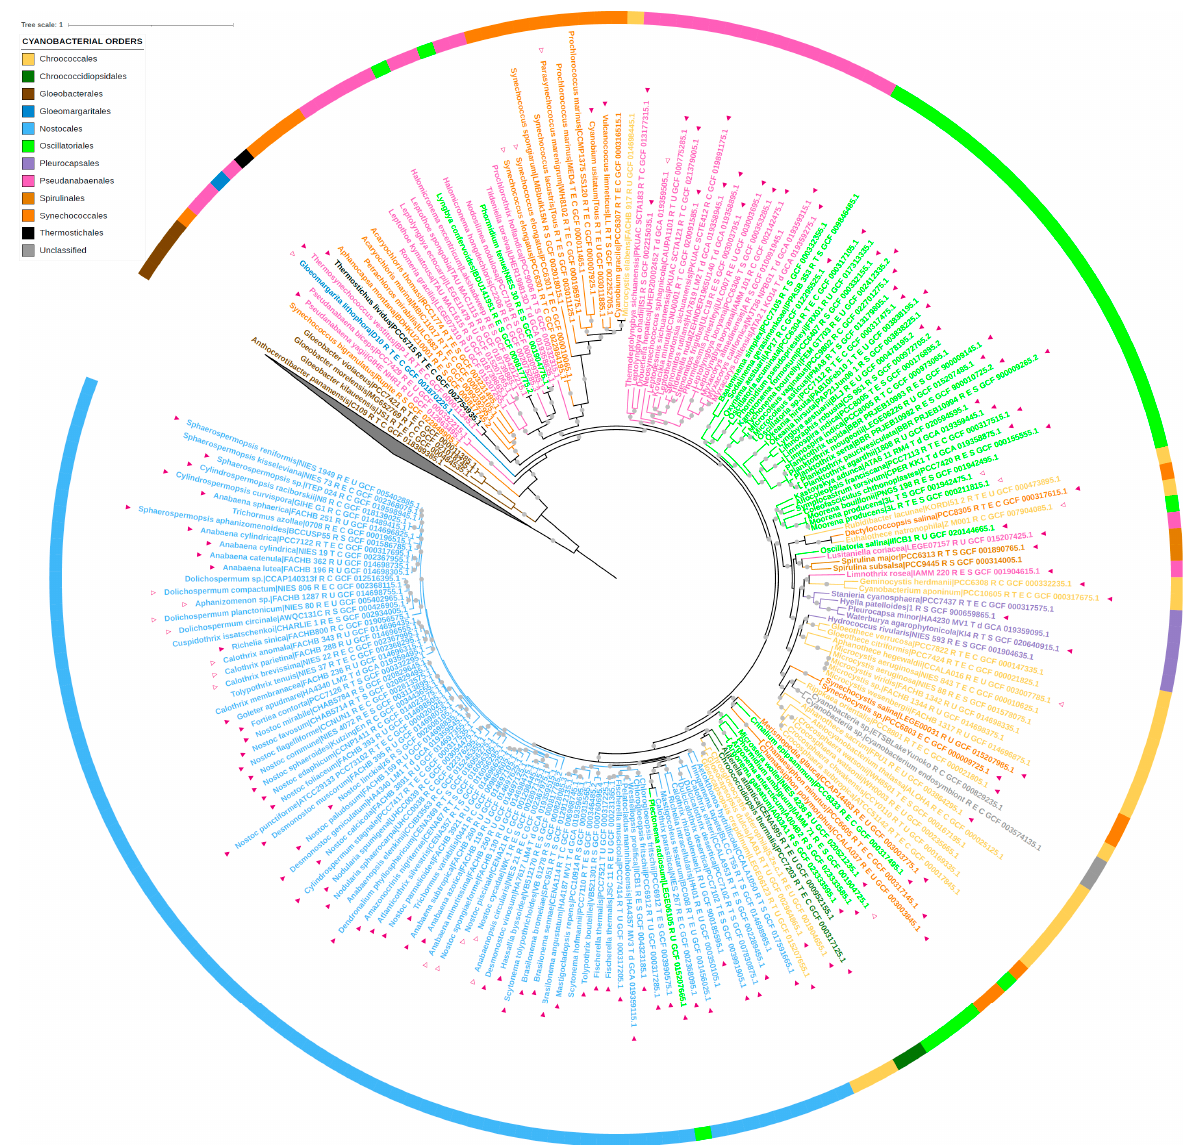
Figure 5. Phylogeny of the 222 proteomes of Cyanobacteria/Melainabacteria group considered in this study. The tree was inferred with IQ-TREE using the 52 rprots sequences present in more than 70% of the 222 proteomes (6430 amino acid sites, LG + C20 + F + R4 evolutionary model). The scale bar corresponds to the average number of substitutions per site. Gray circles correspond to ultrafast bootstrap values >90% (1000 replicates). The taxonomy of each proteome is indicated: Gloeobacterales (brown), Synechococcales (orange), Pseudanabaenales (pink), Gloeomargaritales (dark blue), Thermostichales (black), Oscillatoriales (light green), Chroococcales (yellow), Pleurocapsales (purple), Chroococcidiopsidales (dark green), Nostocales (light blue), and unclassified (gray). The 122 GSTC protein sequences harboring the SRAS motif are indicated with filled triangles, while the 25 GSTC sequences harboring variants of the SRAS motif are indicated with empty triangles. All the motifs are described in the Supplementary Table S8. The phylogeny of these 147 GSTC sequences is shown as Figure S10. A high-quality pdf version of the tree is provided as Figure S11 in the online Supplementary